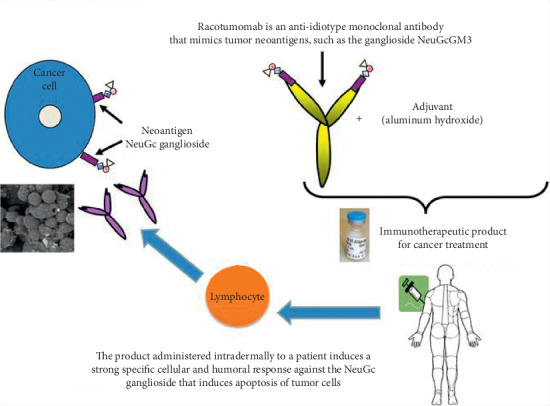
Mechanism of action of Racotumomab [14].